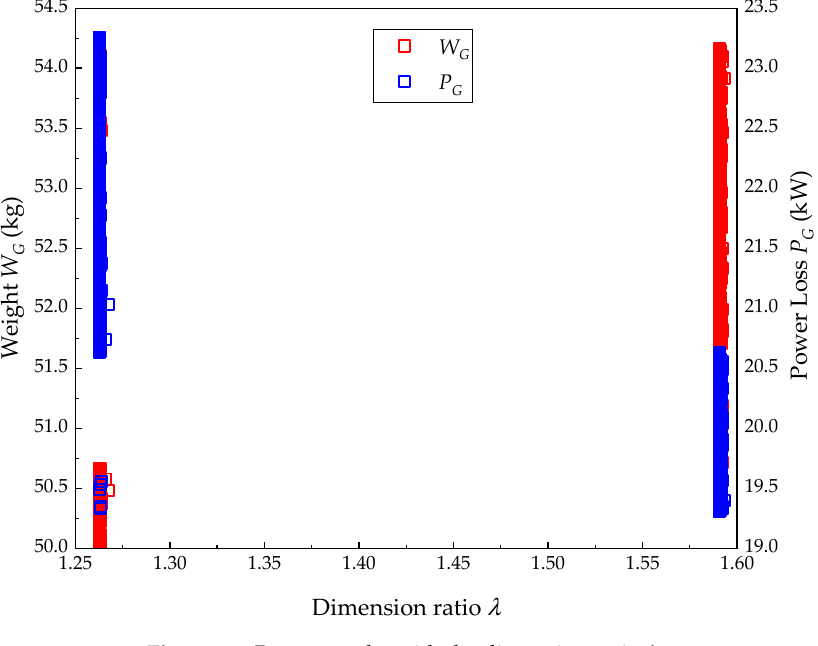
Figure 10. Pareto results with the dimension ratio λ .